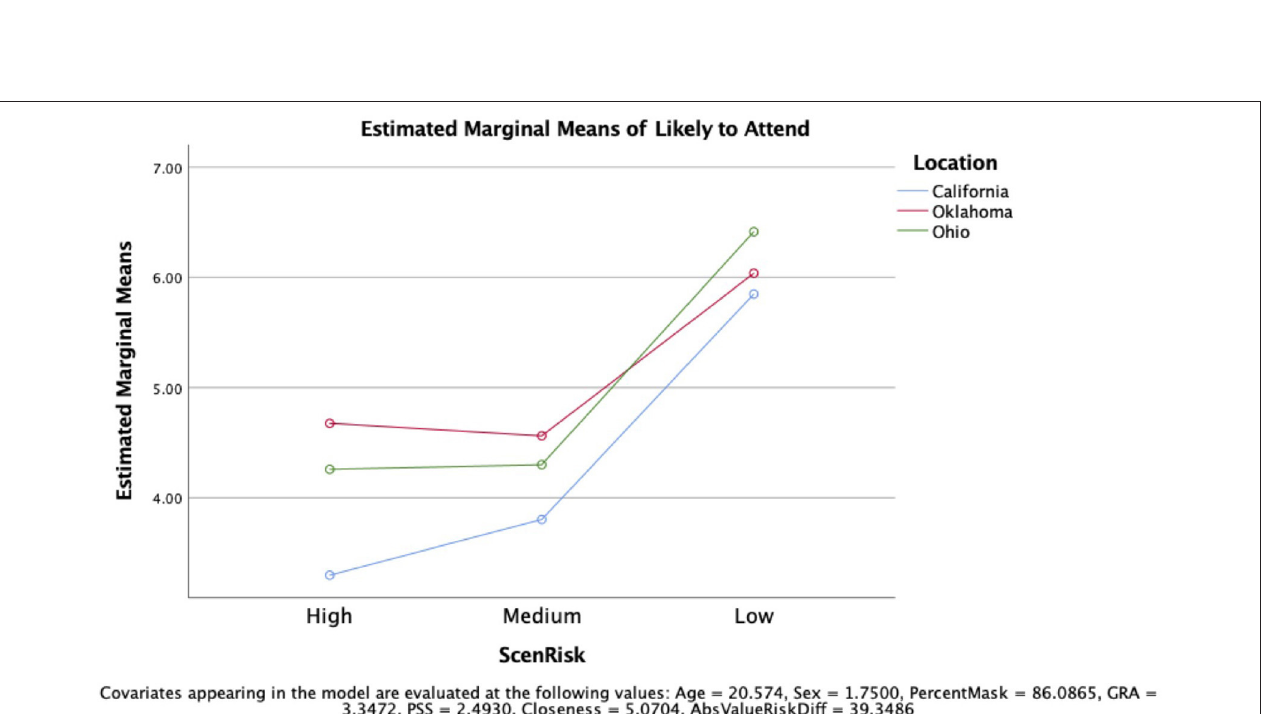
FIGURE 2 | Interaction of risk level and location of data collection to predict reported likelihood of attending an event during the COVID-19 pandemic.